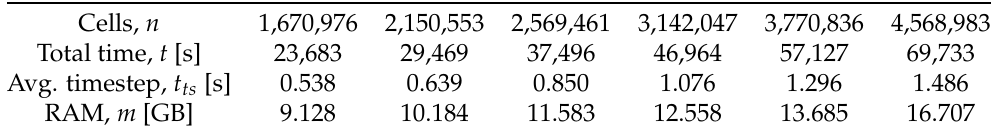
Table A8. Results for setup identical to Table A7 with load balancing enabled and performed when the imbalance reaches 20%.